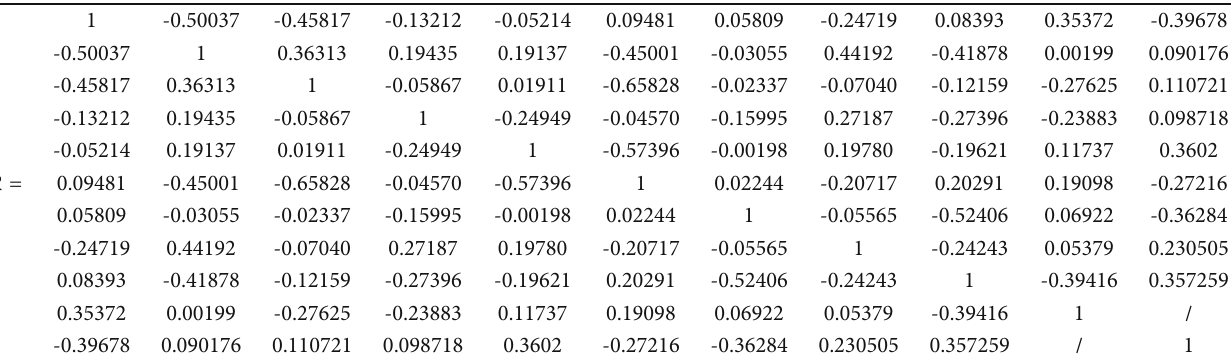
Table 2: The initial correlation coe ffi cient matrix R